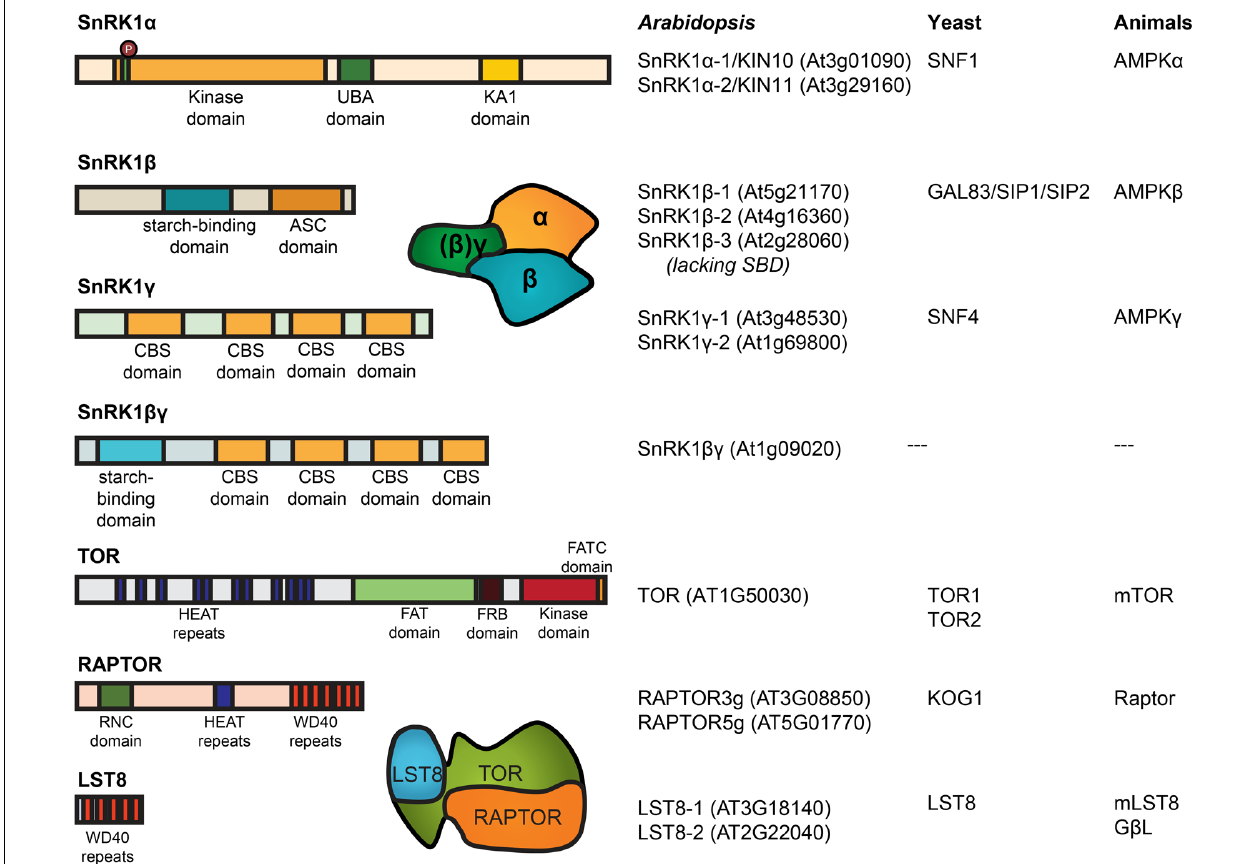
β -synthase (CBS) domains.TOR contain two FAT domains (FRAP, ATM, and TRAP) probably constituting the active center, a PI3K kinase domain, a FRB domain (FKB12-rapamycin binding) for interaction with the inhibitor FKB12, and a number of HEAT repeats [huntingtin, elongation factor 3 (EF3), protein phosphatase 2A (PP2A),TOR1] for the interaction with RAPTOR. Next to HEAT repeats, RAPTOR contains a RNC domain (raptor N-terminal conserved/putative caspase domain) and a number ofWD40 repeat domains (Hay and Sonenberg, 2004). Nomenclature as described before (Robaglia etal.,